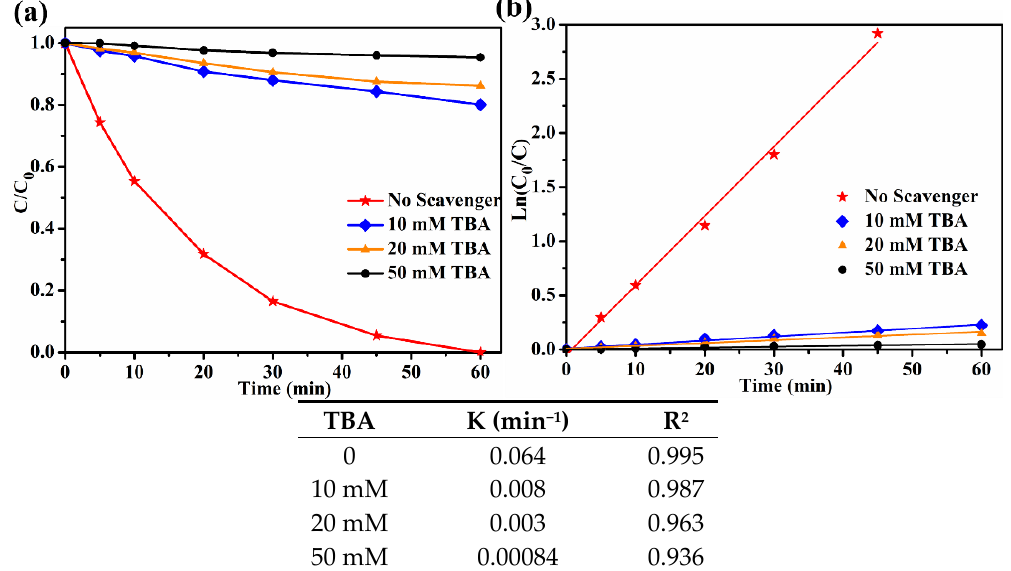
Figure 11. ( a ) Effect of free radical inhibition by varying concentrations of TBA on ATL degradation. ( b ) Pseudo- first-order model.